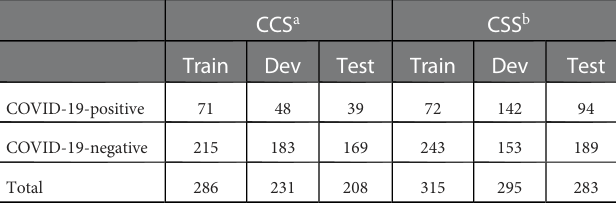
TABLE 1 ComParE COVID-19 sub-challenges dataset splits. Values specify the number of audio recordings. We note that disjoint participant train, development, and test splits were